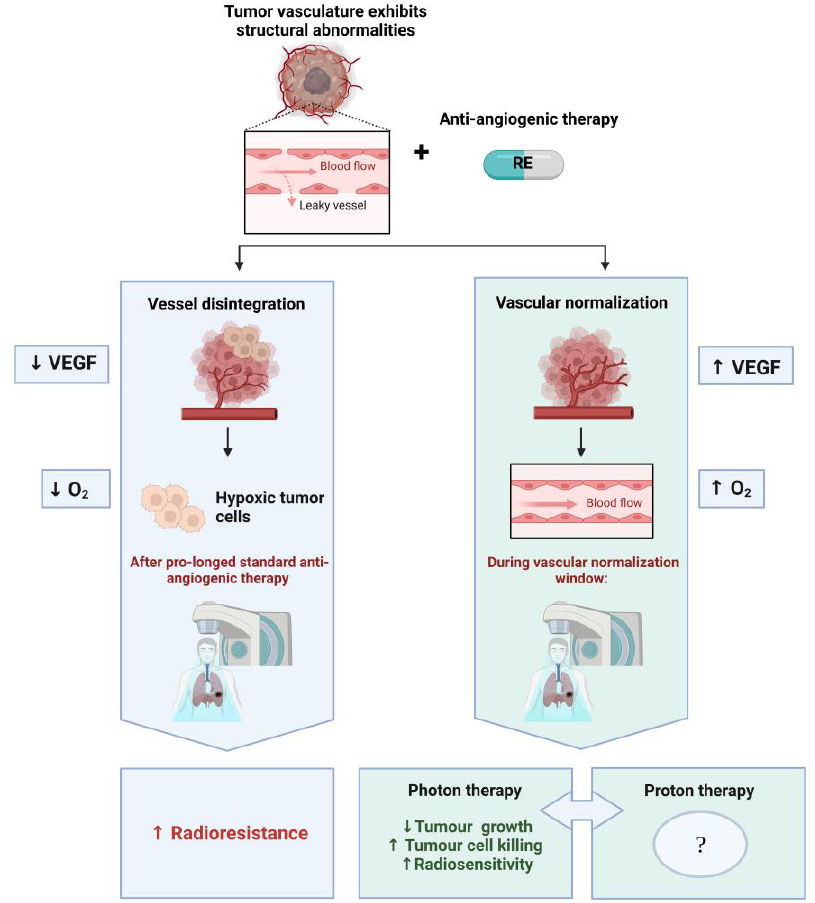
Figure 2. The paradoxal combination of RE and RT. The left-hand side (blue) illustrates the initial approach, where anti-angiogenic therapy blocks the formation of blood vessels and enhances hypoxia within the tumour, due to the reduction of blood vessels, resulting in increased radioresistance during RT. If one administers RE at a well-defined dose, a normalization window will appear at a given time (variable timing depending on tumour type, administration route, and dose). In this case, the RT can benefit from vascular normalization (right column—green), which induces the conversion of a chaotic to a more normal vascular network in the tumour and results in an enhancement of tumour oxygenation and radiosensitivity. This contributes to increased tumour control and tumour cell killing in experimental studies with X-ray (photon)-based RT. No preclinical or clinical studies are currently available on the combination of RE with proton therapy, which calls for further investigation to decipher the combined effects. Figure was created with BioRender.